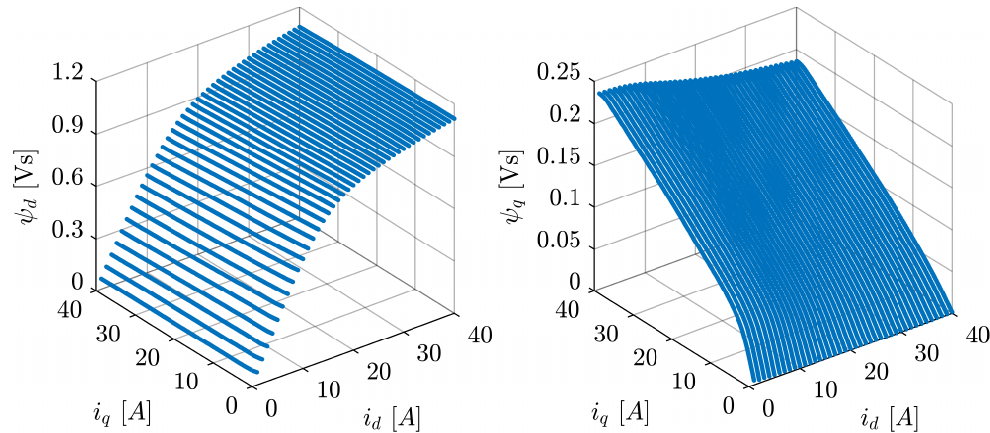
Figure 14. Estimated flux linkage samples d -axis ( left ) and q -axis ( right